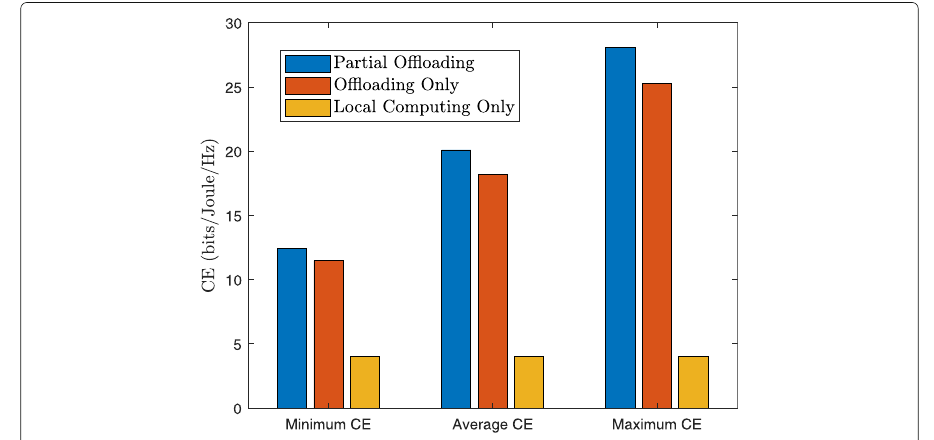
Fig. 7 Comparison of fairness among different computing